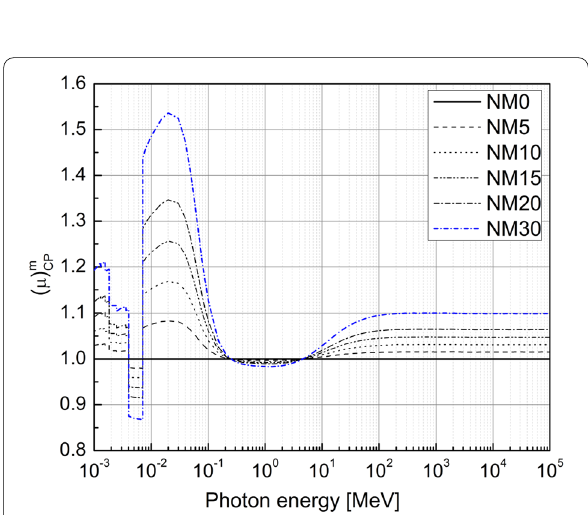
Fig. 12 The normalized linear attenuation values with respect to the control